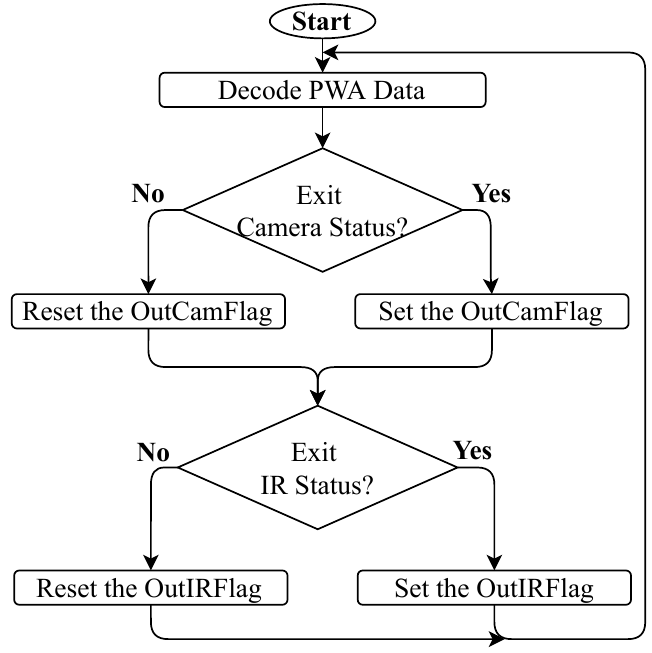
Figure 14. Flowchart of Exit decoder